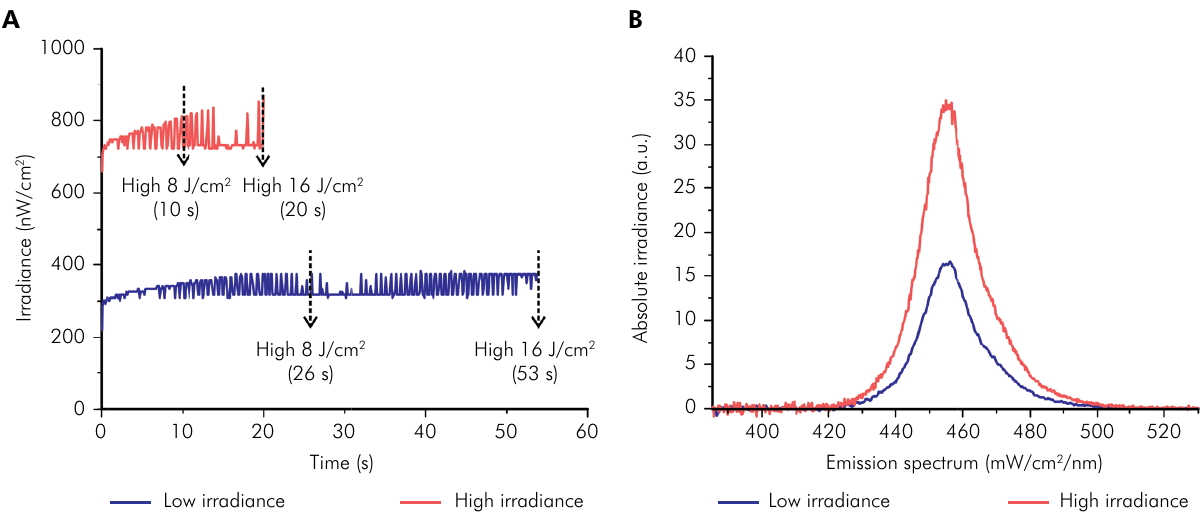
Figure 1. [A] Irradiance variation (mW/cm 2 ) and [B] Emission spectrum (mW/cm²/nm) of the photopolymerization unit used in this